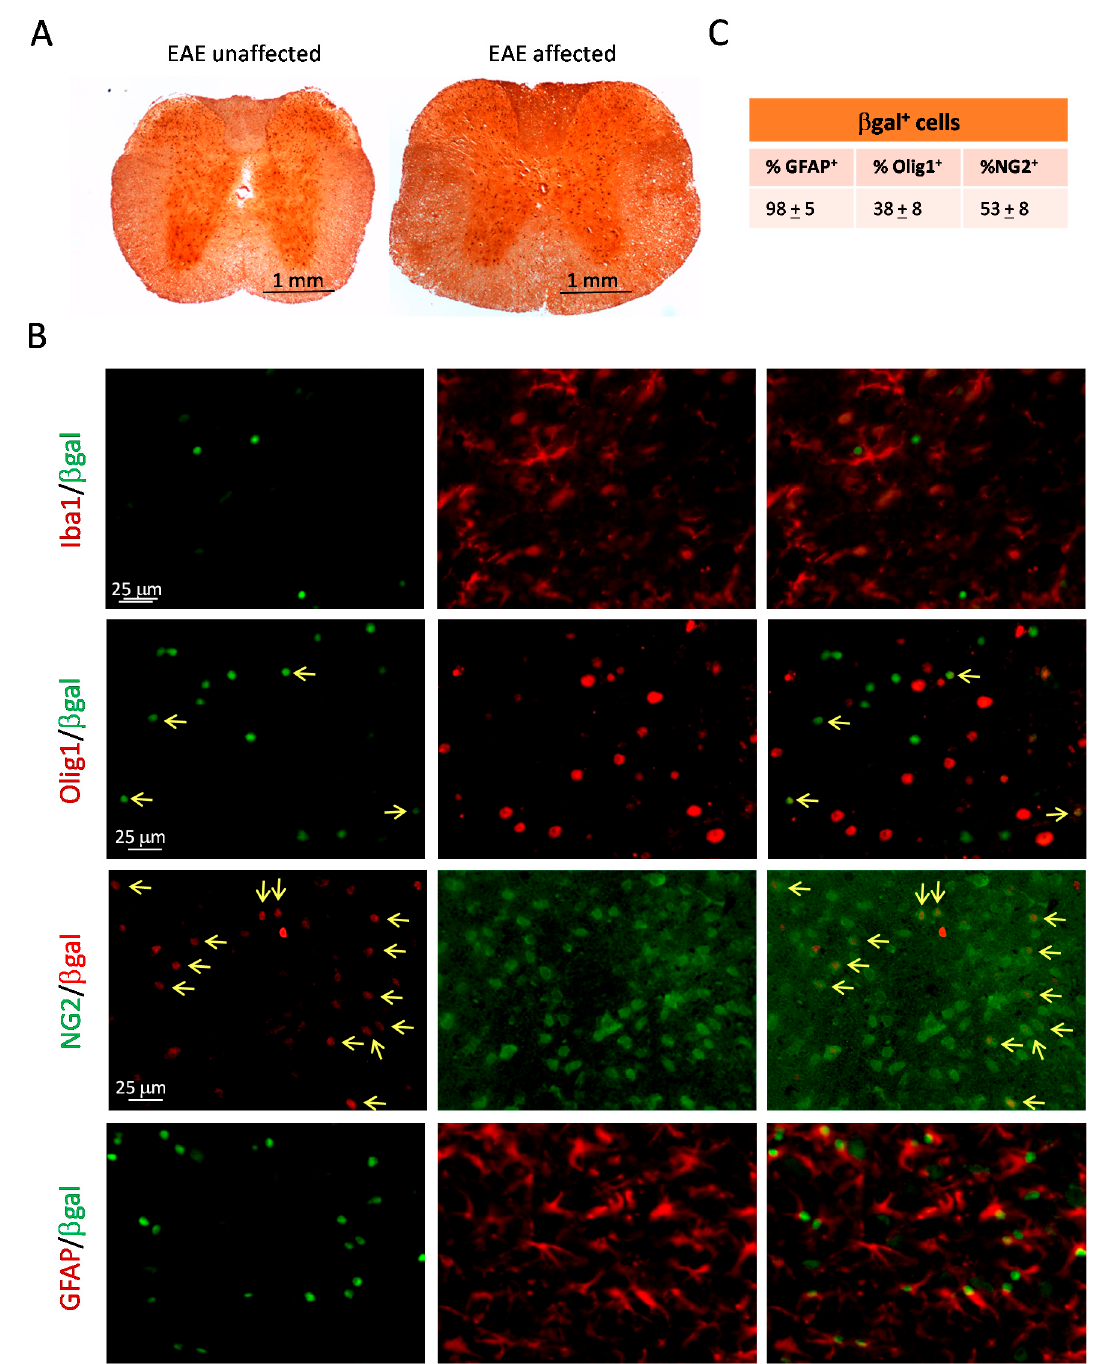
Figure 8. Detection of β -gal-positive cells in ptch +/ − mice. ( A ): Immuno-histochemistries by using anti- β gal antibody in cross-sections of spinal cords from ptch +/ − mice inoculated with MOG 35–55 after 20 days from inoculation. Samples from mice with different clinical scores are shown (symptomatic, clinical score: 4 or asymptomatic, clinical score: 0). ( B ): Double immunofluorescence analyses of spinal cords from symptomatic ptch +/ − mice for β -gal and Iba1 (first row, green nuclei and red cytoplasm), Olig1 (second row, green or red nuclei), NG2 (third row, red nuclei and green cytoplasm) or GFAP (fourth row, green nuclei and red cytoplasm). Last column shows the merged images; yellow arrows point to double-positive cells. ( C ): Percentages of β gal + cells co-expressing GFAP, Olig1 or